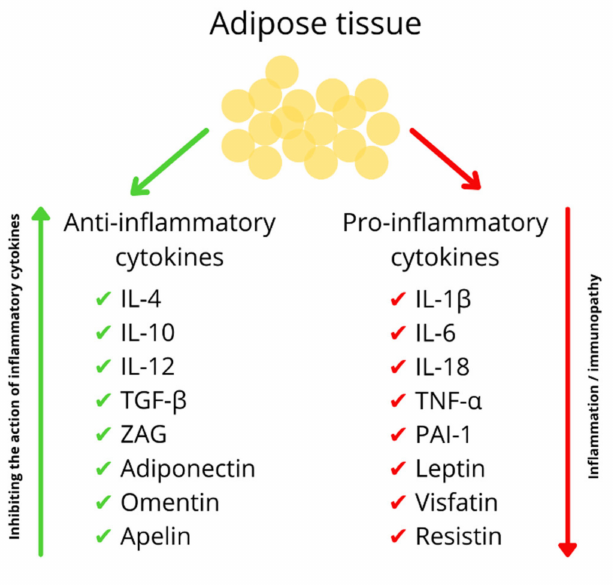
Figure 2. Adipokines produced by the adipose tissue. IL-4—interleukin 4, IL-10—interleukin 10, IL-12 -interleukin 12, TGF- β —transforming growth factor beta, ZAG—zinc- α 2-glycoprotein, IL-1 β — interleukin 1 beta, IL-6—interleukin 6, IL-18–interleukin 18, TNF- α —tumour necrosis factor-alpha, PAI-1—plasminogen activator